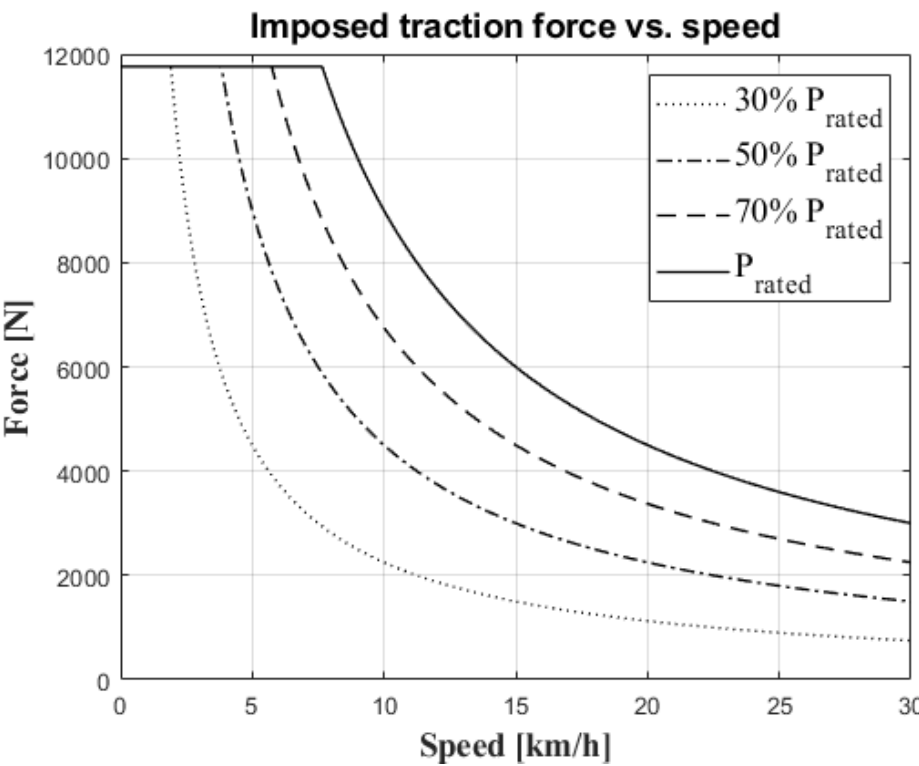
Figure 11 . Imposed traction force for transmission characterization . Figure 11. Imposed traction force for transmission characterization.